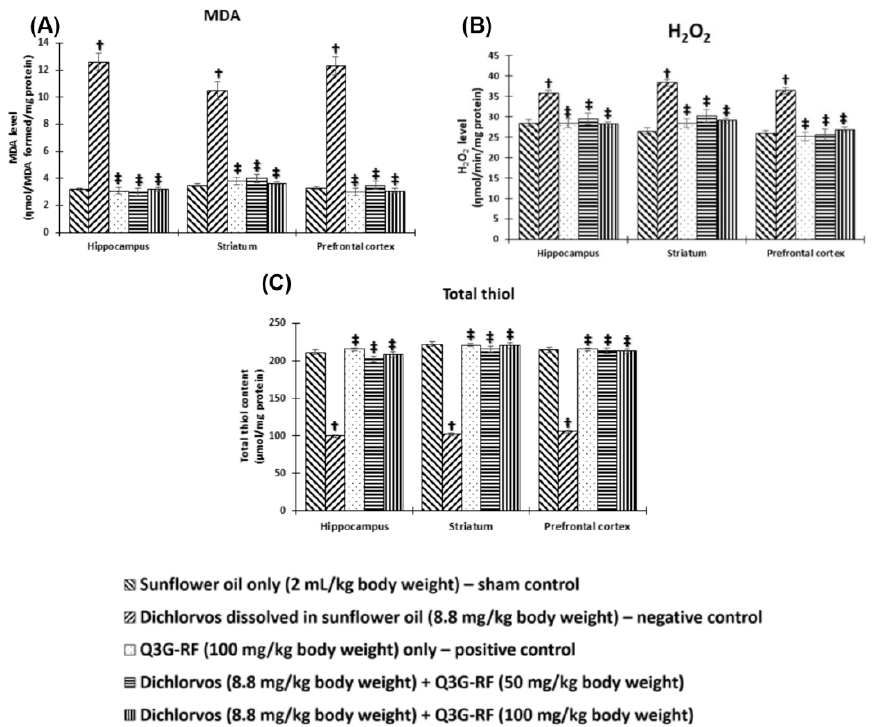
Figure 4. Impact of Q3G-RF from S. mombin leaves on oxidative stress markers in the brain of DDVP- induced neural impairment of female Wistar rats. MDA ( A ), H 2 O 2 ( B ), and total thiol content ( C ) of Wistar rats treated with sunflower oil, DDVP alone, Q3G-RF alone, and DDVP + Q3G-RF (50 and 100 mg/kg). Values are expressed as mean ± standard error of mean ( n = 10). Significant differences from the positive control group are indicated by † and from DDVP alone by ‡ , ( p < 0.05). DDVP, Dichlorvos; Q3G-RF, Quercetin-3-O- β -D-glucopyranoside-rich fraction from Spondias mombin .